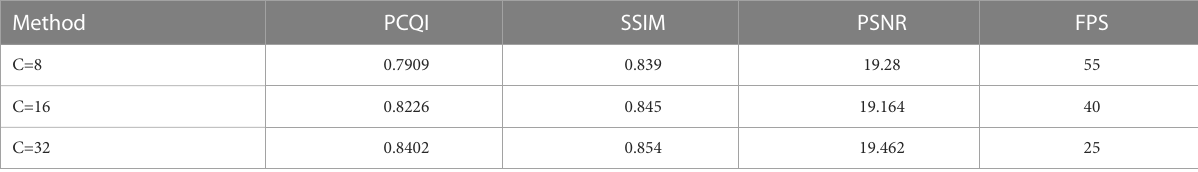
TABLE 11 PCQI, SSIM, PSNR, and FPS comparison on the UIEB dataset using different network widths.